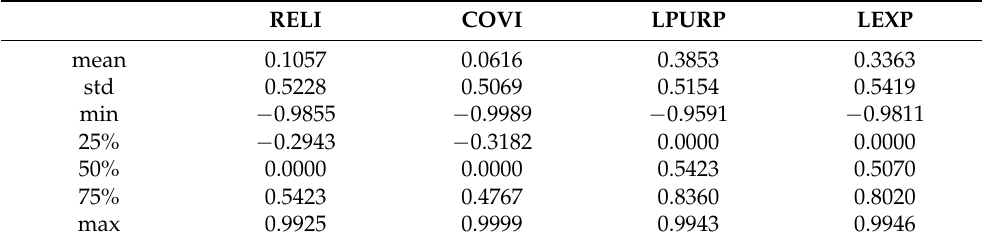
Table 1. Descriptive